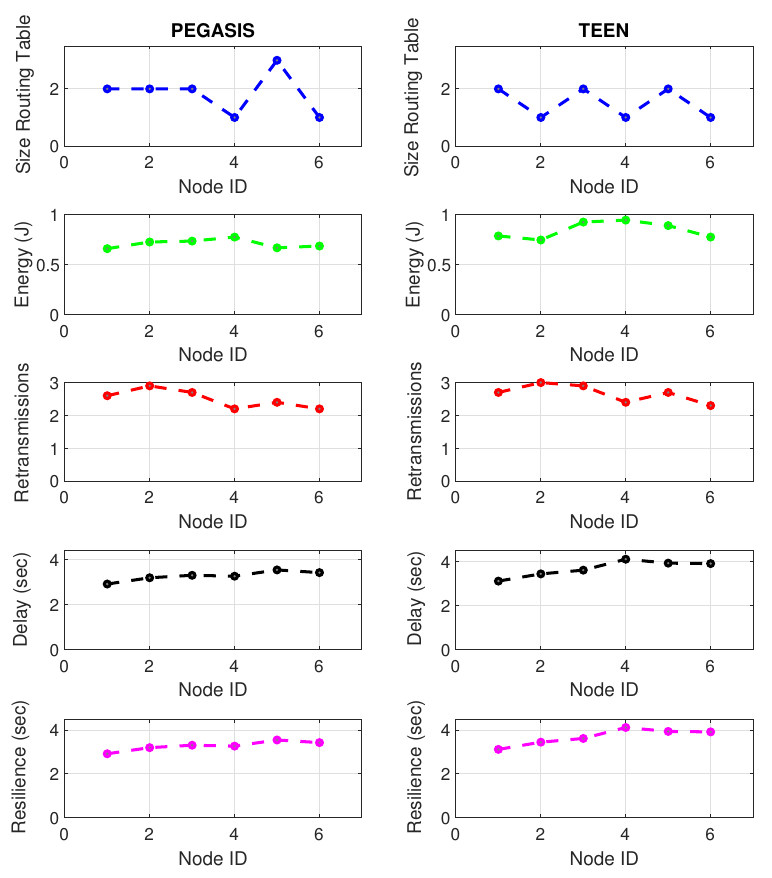
Figure 22. LoRa network deployment under jamming